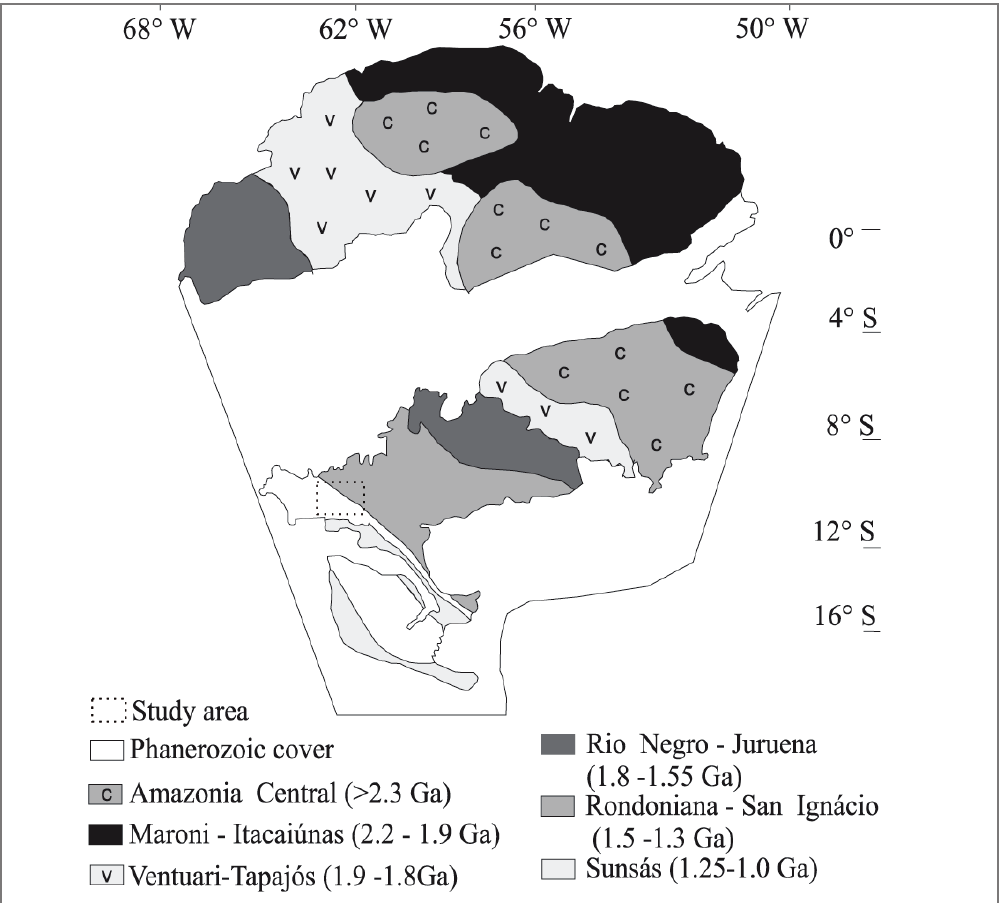
FIGURE 1 – Subdivisions of the Amazonian Craton according to Tassinari and Macambira (1999). The black-dotted rectangle shows the localization of the central portion of the Rondônia Tin